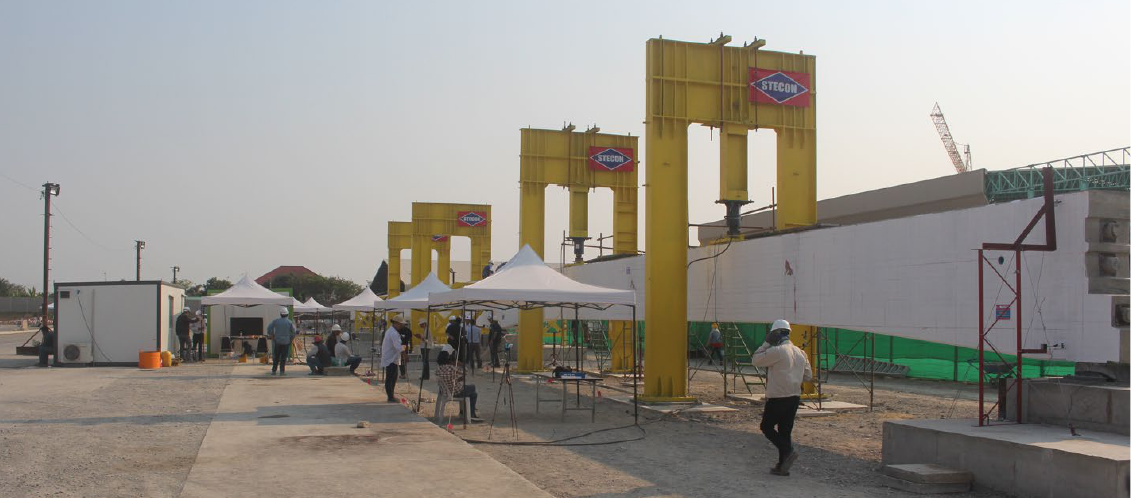
Figure 12. Typical load setup SP-1-L03 and SP-1-L04.